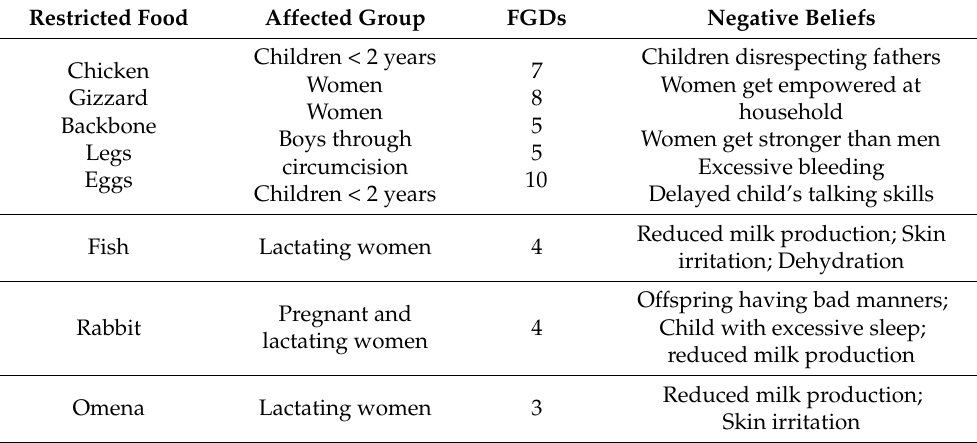
Table 7. Food taboos restricting the consumption of animal-protein foods reported in Vihiga County,